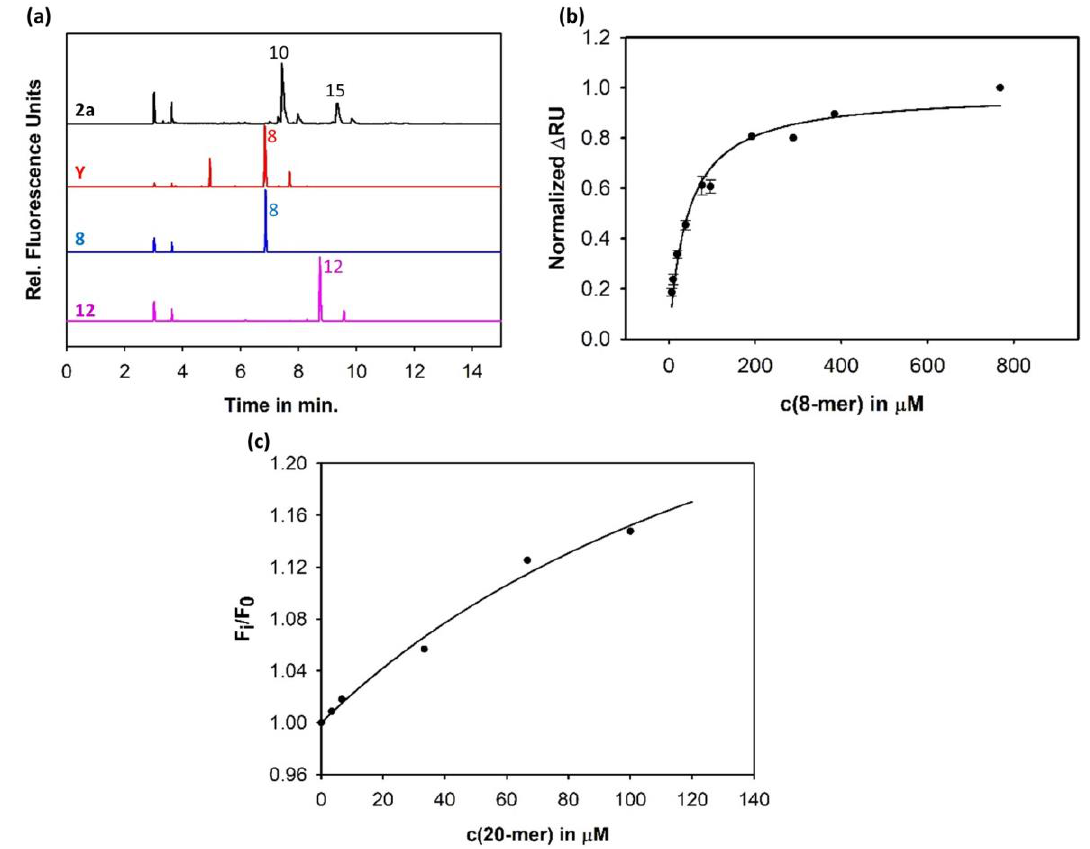
Figure 1. ( a ) Capillary electrophoresis laser induced fluorescence CE-LIF analysis of oligosaccharide products obtained by Sf6TSP cleavage from S. flexneri lipopolysaccharide (LPS) preparations of serotype Y (red) or 2a (black). Purified serotype Y dodecasaccharide (violet) or octasaccharide (blue) standards are also shown and numbers indicate the size of the oligosaccharide fragments. ( b ) Normalized surface plasmon resonance signals of S. flexneri oligosaccharides binding to surface-immobilized Sf6TSP E366A/D399A at 25 °C. The solid line represents the isotherm obtained from the fit to a single independent binding site model and yielded a K D of 42.81 ± 6.69 μM for the octasaccharide ligand. Standard deviations from three independent measurements are indicated at selected concentrations. ( c ) Increase of Sf6TSP E366A/D399A intrinsic protein fluorescence upon addition of a synthetic S. flexneri serotype 2a fragment: [ → 2)-α- L -Rha p III-(1 → 2)-α- L -Rha p II-(1 → 3)-[α- D -Glc p -(1 → 4)]-α- L -Rha p I-(1 → 3)-β- D -Glc p NAc-(1 → ] 4 -O(CH 2 ) 2 NH 2 in 50 mM sodium phosphate